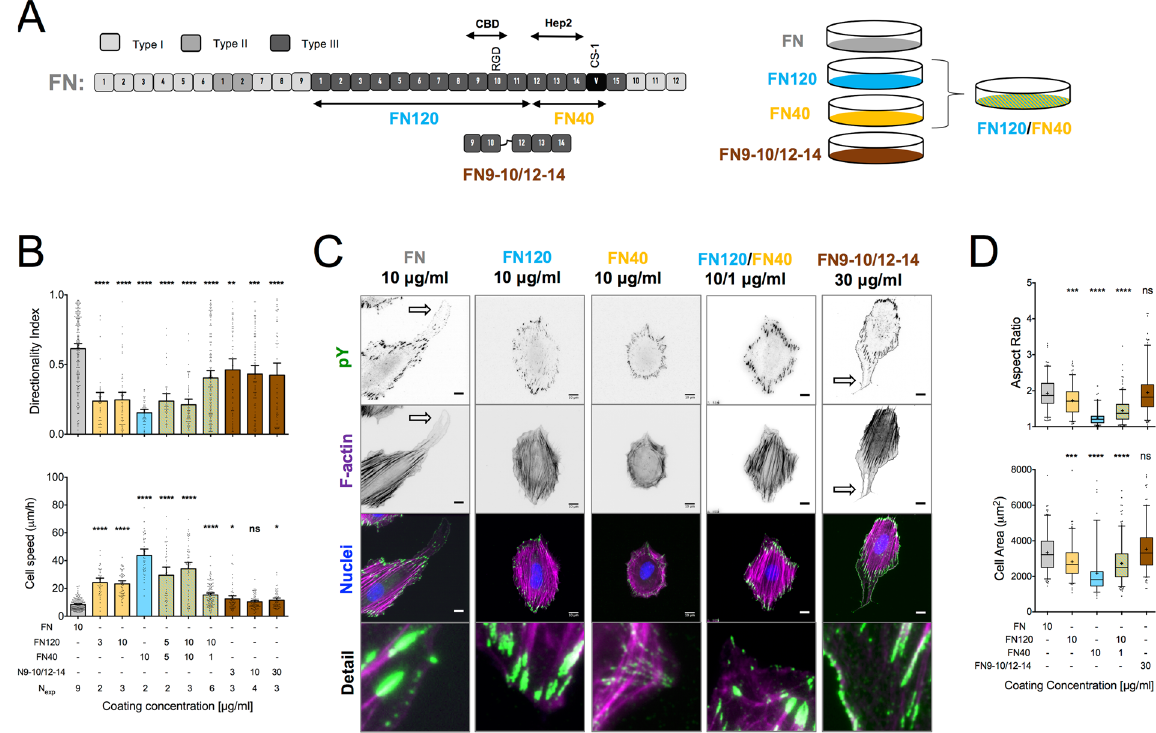
Figure 1. Signals from both the cell binding and C-terminal heparin-binding domains of FN are required for high directional persistence in fibroblast migration. ( A ) Schematic representation of plasma FN, showing the location of the different domains, the proteolytic fragments and recombinant fragments relevant for this study. Substrates were coated with FN, FN fragments or their combinations (color coded). ( B ) Cell speed and directionality index (distance from the origin divided by the trajectory length) were calculated for single REF migrating on indicated substrates for 16 hours. Cell speed was the lowest and directionality index was the highest on FN-coated substrates. N exp : number of independent experiments. Mean ± s.e.m. are presented. ( C ) Epifluorescence microscopy images of REF seeded for 6 hours on indicated substrates revealed important differences in adhesion cluster formation and F-actin cytoskeletal organization (see main text for details). Polarized protrusions are indicated by block arrows on FN and FN9–10/12–14. ( D ) REF projected cell area and aspect ratio, 6 hours post-seeding on substrates coated with FN or FN fragments. Results from > 150 cells and 2 independent experiments are presented. The middle line in box plots indicates the median, the box indicates the interquartile range, the whiskers the 5 th and 95 th percentiles and the cross the mean. Scale bars: 10 μ m. Data in ( B , D ) were compared to control FN-coated substrates using one-way ANOVA analysis. ns: not significant; * P < 0.05, ** P < 0.01, *** P < 0.001, **** P <